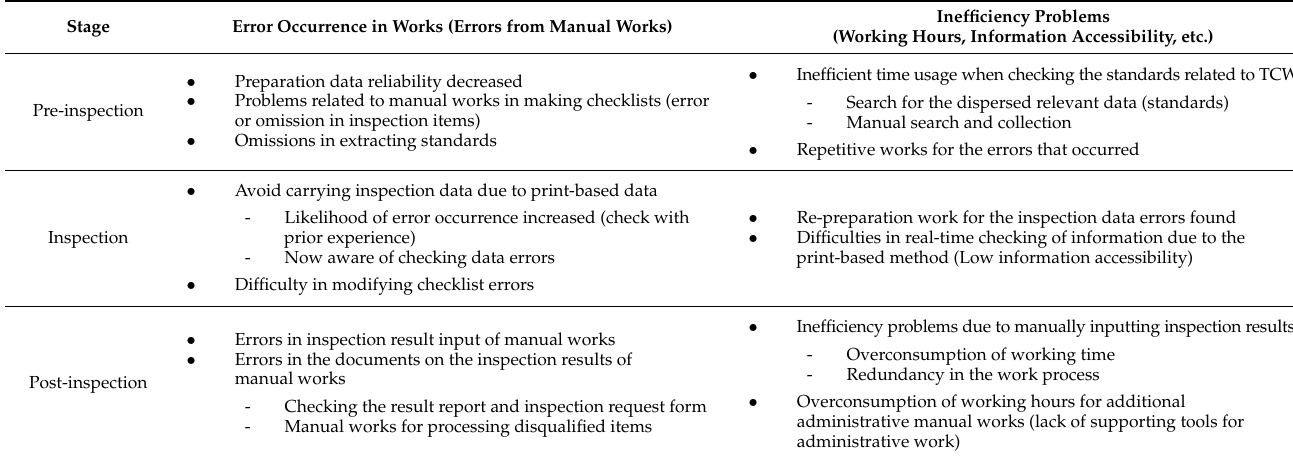
Table 2. Problems in QM engineers’ inspection work for